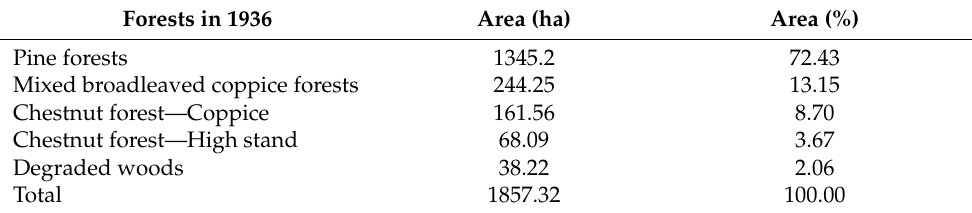
Table 2. Different types of forest cover for the area of the Cinque Terre National Park (5TNP) in 1936.